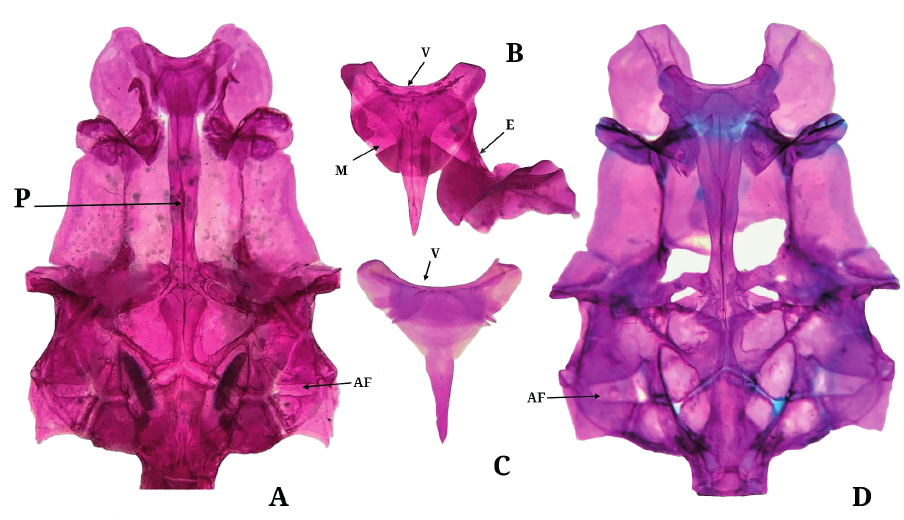
FIGURE 2 | Ventral view of the neurocranium, in specimens cleared and stained. A. Tlaloc portillorum (MZ-UNICACH 7222, 70.5 mm SL); B. Vomer region of T. candalarius (MZ-UNICACH 3899, 61.7 mm SL); C. Vomer region of Profundulus kreiseri (MZ-UNICACH 7214, 59.6 mm SL); and D. Neurocranium of P. mixtlanensis (MZ-UNICACH 6716, 55.6 mm SL). Abbreviations: V, vomer (Y-shaped); E, lateral ethmoid; M, mesethmoid; P, parasphenoid; AF, autopterotic